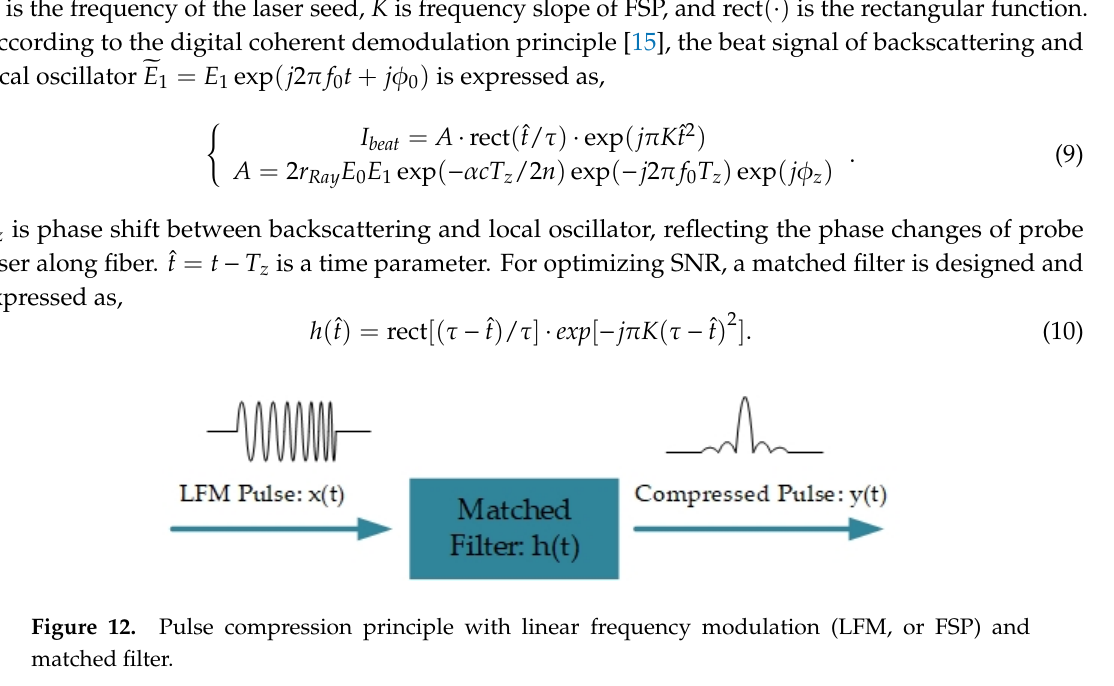
Figure 13. Experimental setup. Reproduced with permission from our previous paper [22], published by Optical Society of America, 2017.